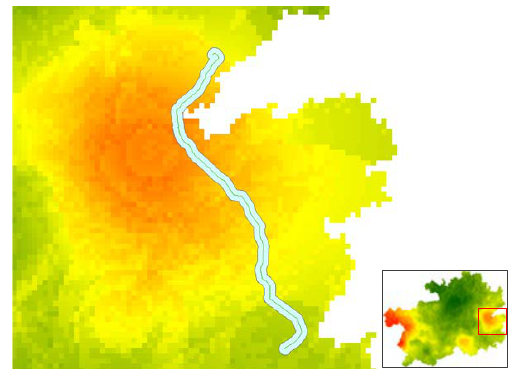
Figure 8 Buffer of Tongli Line on PLMRI raster map